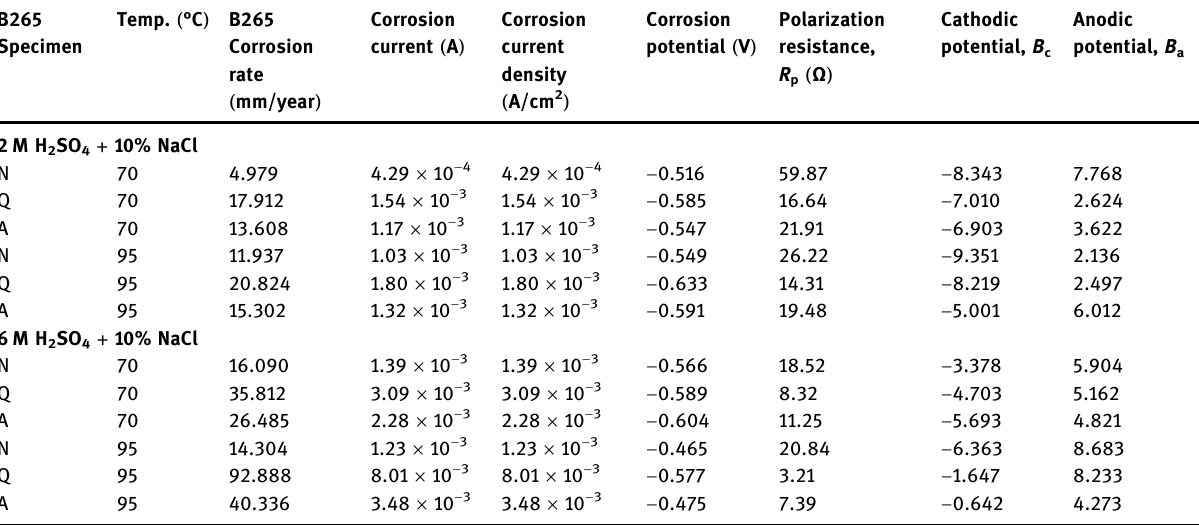
Table 3: Potentiodynamic polarization data for B265TiN, B265TiQ, and B265TiA in 2 M H 2 SO 4 + 10% NaCl and 6 M H 2 SO 4 + 10% NaCl at